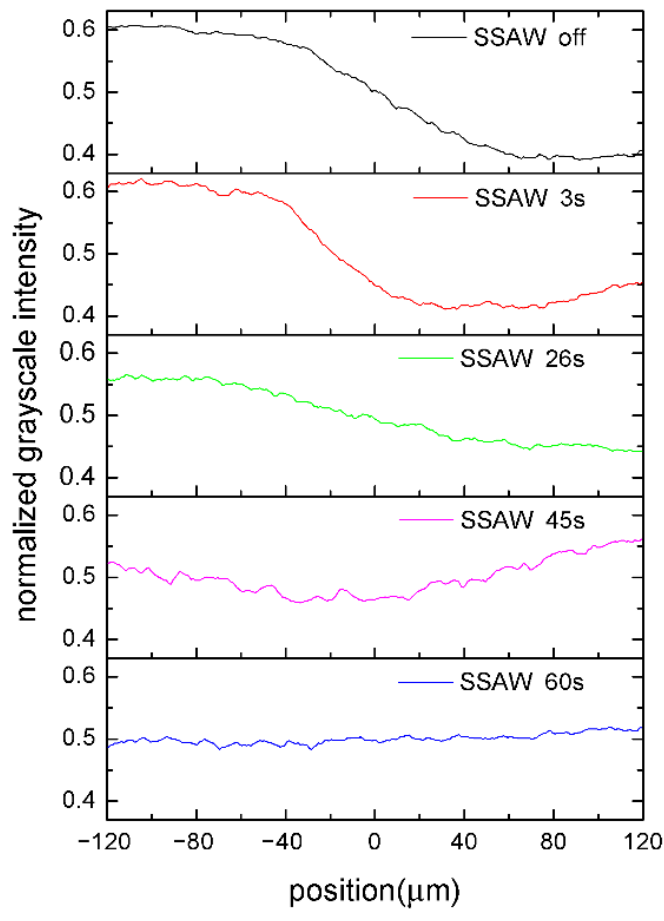
Figure 4. The normalized dye intensity distributions along channel width.